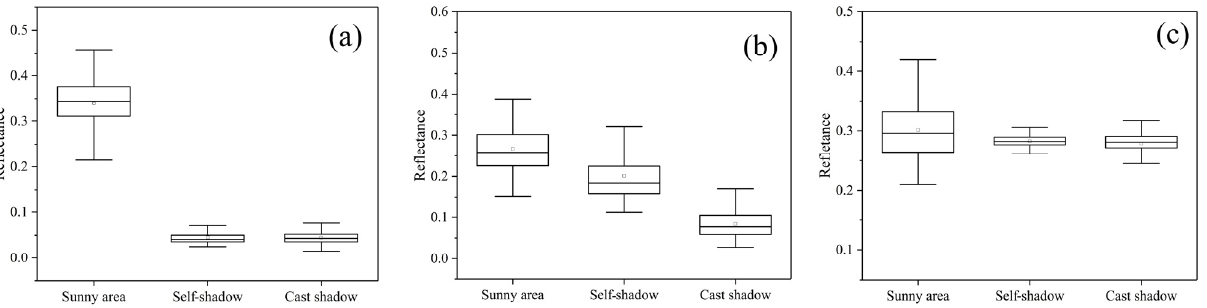
Figure 5. Box plot of the corrected near-infrared (NIR) waveband reflectance: ( a ) ρ , ( b ) SCS + C, and ( c ) +S.